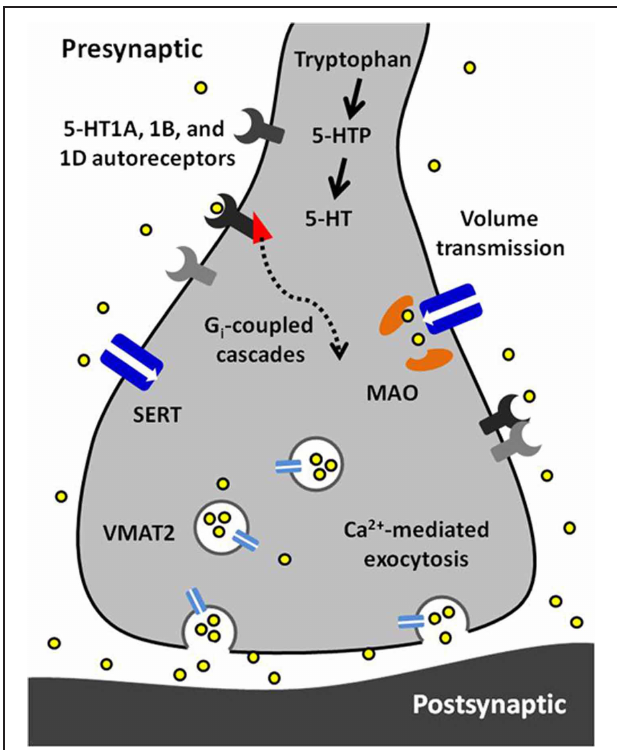
FIGURE 5 | A synopsis of the findings presented in this article. Serotonin (5-HT) is synthesized from tryptophan in a two-step process requiring tryptophan hydroxylase and aromatic amino acid decarboxylase. Serotonin is packaged into vesicles by vesicular monoamine transporter 2 (VMAT2) and is released via calcium-dependent exocytosis. Released serotonin diffuses to extrasynaptic receptors and transporters via volume transmission. Its autoreceptors (5-HT1A, 1B, and 1D) are inhibitory and coupled to G i proteins. The serotonin transporter (Thienprasert and Singer) has high affinity and selectivity for uptake of extracellular serotonin. Inside the terminal, serotonin is primarily metabolized by monoamine oxidase